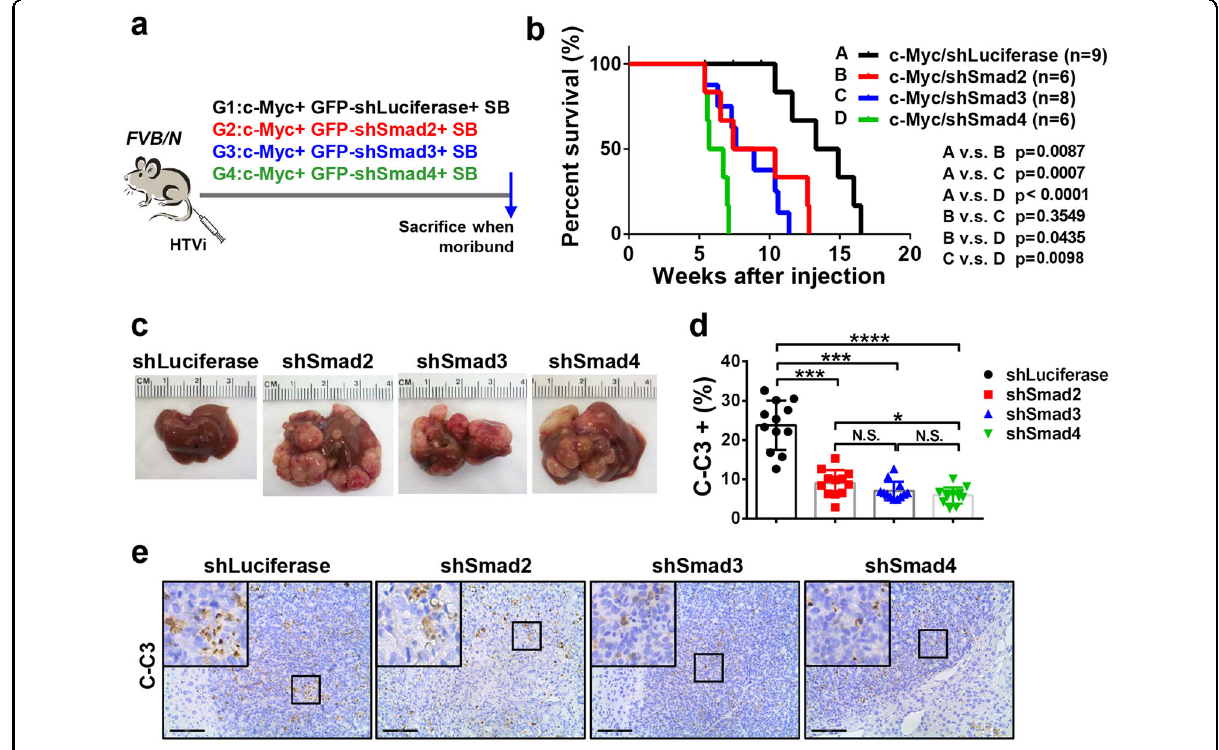
Fig. 3 Inhibition of TGF β -SMAD signaling pathway accelerates c-Myc liver tumorigenesis in mice. a Study design. FVB/N mice were hydrodynamically injected (HTVi) with c-Myc/GFP-shLuciferase/SB ( n = 9), c-Myc/GFP-shSmad2/SB ( n = 6), c-Myc/GFP-shSmad3/SB ( n = 8) and c- Myc/GFP-shSmad4/SB ( n = 6) plasmids, respectively. Mice were monitored and sacri fi ced when moribund. b Survival curve showing that inhibition of Smad2, Smad3 or Smad4 accelerates c-Myc induced hepatocarcinogenesis in mice. Kaplan – Meier method and log-rank test were applied. P -values were shown in the fi gure. c Representative images of tumors in the four groups at 5 weeks post injection (p.i.). d Comparison of cleaved caspase 3 (C- C3) positive cells percentages in the four groups. Student t- test was applied between each 2 groups for statistical analysis, * P < 0.05, *** P < 0.001, **** P < 0.0001, N.S., no signi fi cance. e Representative images of cleaved caspase 3 (C-C3) immunohistochemical staining in c-Myc/shLuciferase (shLuciferase), c-Myc/shSmad2 (shSmad2), c-Myc/shSmad3 (shSmad3) and c-Myc/shSmad4 (shSmad4) mouse HCCs. Scale bars: 200 μ